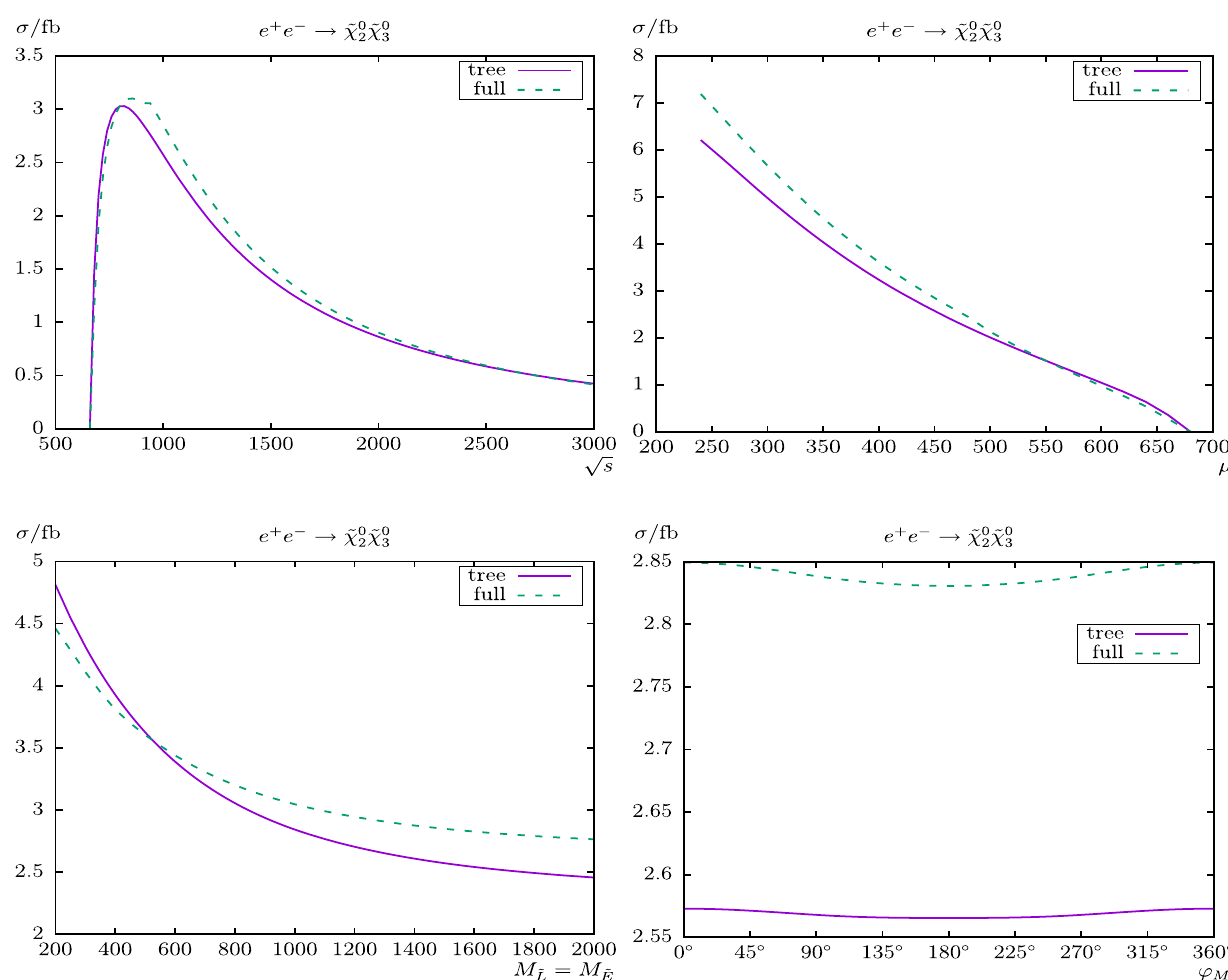
˜ χ 0 ) . Tree-level and full one-loop corrected cross sections are shown with parameters chosen according to S ; see Table 2. √ 2 3 s (left) and μ (right) varied; the lower plots show M ˜